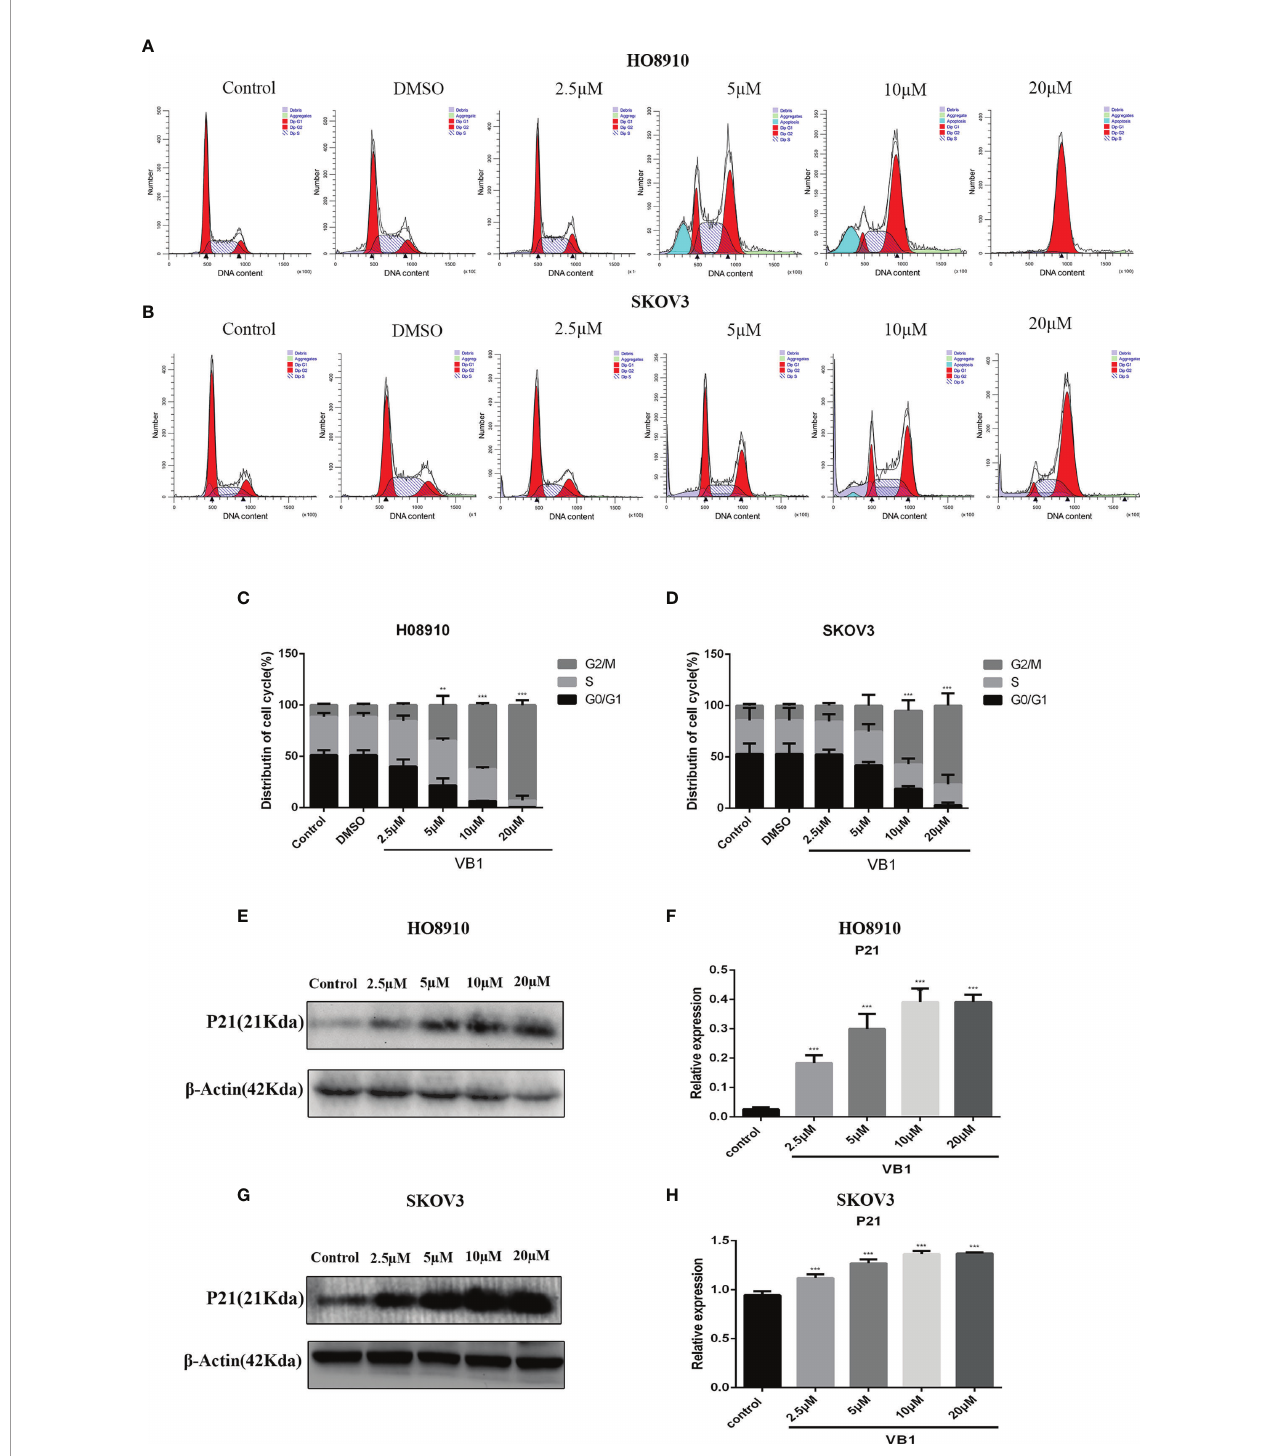
FIGURE 3 | VB1 induces G2/M arrest in human ovarian cancer cells. (A – D) H08910 and SKOV3 cells were exposed to VB1 (0 µM), 0.1% DMSO, and VB1 (2.5 – 20 µM) for 24 h; the fl ow cytometry was performed to detected distribution of cell cycle. (E, F) The expression of P21 in HO8910 cells which were treated with VB1 (0 – 20 µM) for 24 h. Western blotting was performed by p21 antibody. (G, H) The expression of P21 in SKOV3 cells which were treated with VB1 (0 – 20 µM) for 24 h, Western blotting was performed by p21 antibody. The results represent the mean ± SD of three independent experiments. **P < 0.01, ***P < 0.001 compared with the control